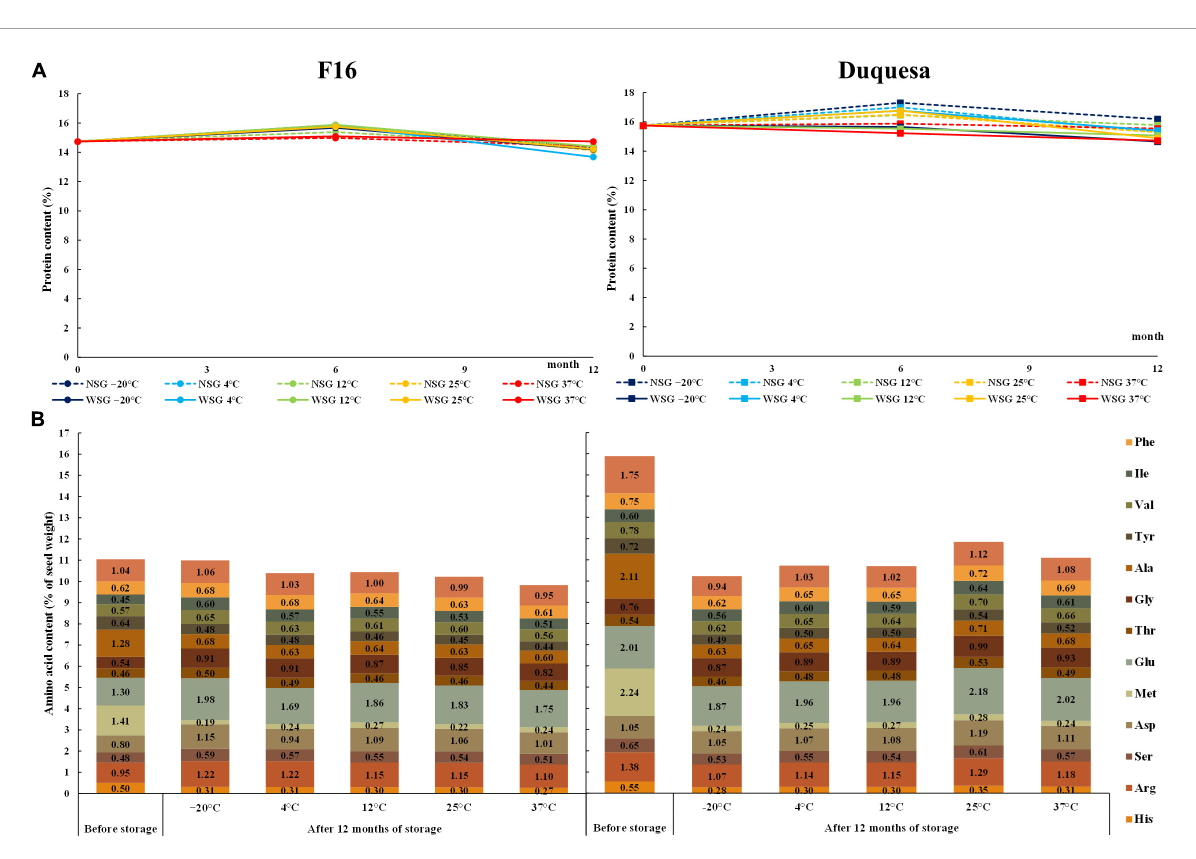
FIGURE2 Change in seed protein content and composition over storage time. (A) Protein content measured with a nitrogen-to-protein conversion factor of 6.25 in F16 (left) and Duquesa seeds (right) over storage time. NSG: seeds stored without silica gel. WSG: seeds stored with silica gel. (B) Amino acid contents expressed as percentage of seed weight in F16 seeds (left) and Duquesa seeds (right) stored without silica gel, measured before storage and after 12 months of